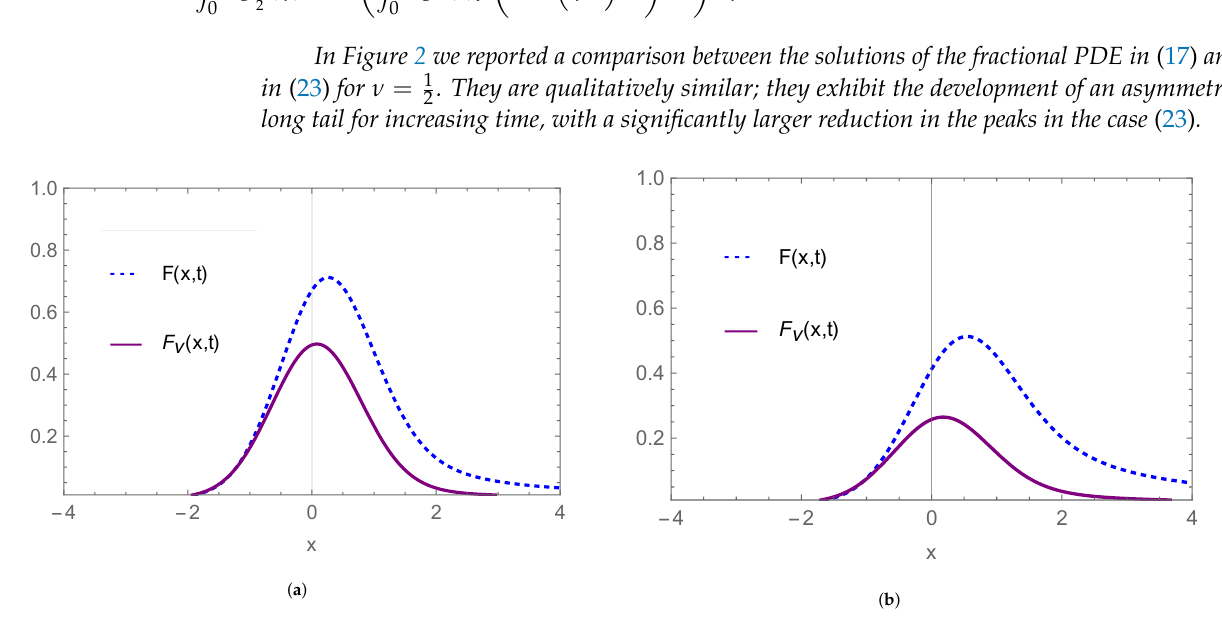
and different values of t . ( a ) t = 0.5; 2